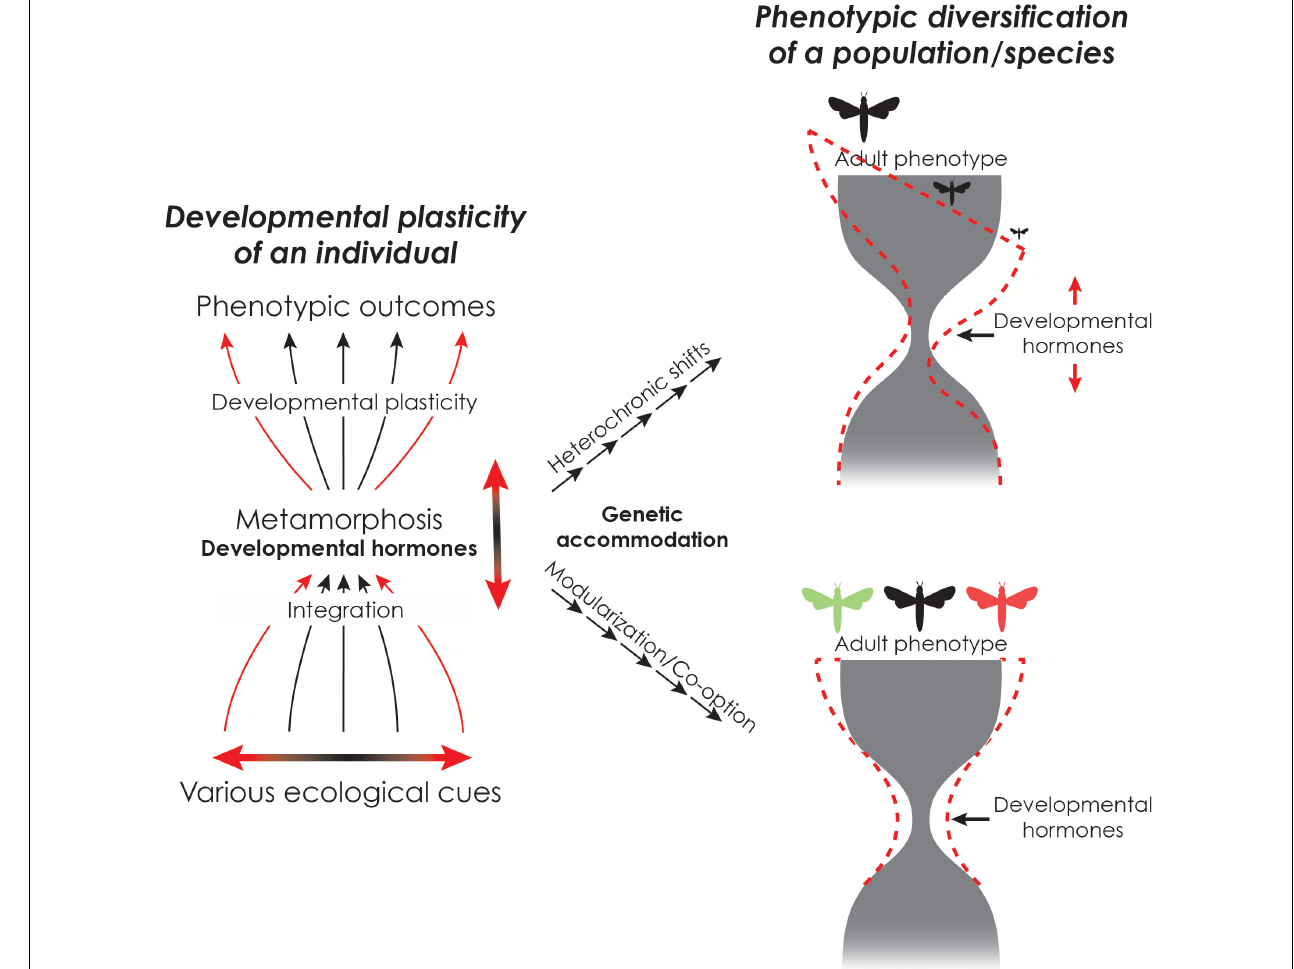
FIGURE 6 | Genetic accommodation via endocrine changes leads to changes in body size and morphology.(Left) Developmental plasticity of an individual. Extreme environmental conditions can lead to changes in the timing of metamorphosis or adult morphogenesis through changes in the timing and amount of endocrine action (solid red lines). (Right) Such changes can be selected for and become genetically accommodated in a population over multiple generations, leading to changes in phenotypic diversity (dotted red